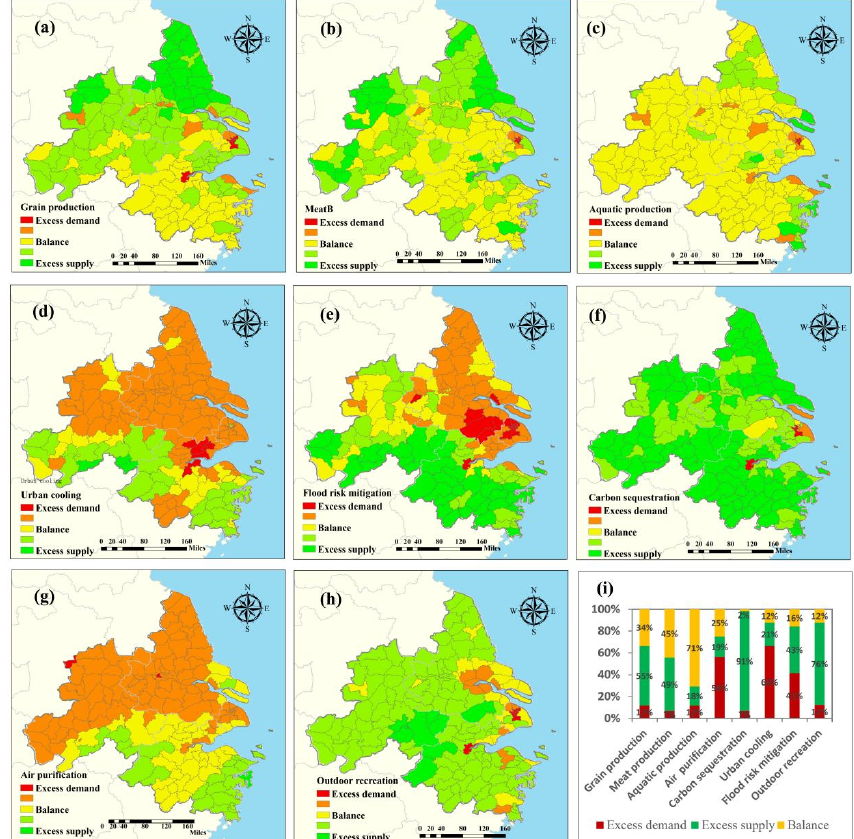
Figure 7. The spatial patterns of paired ES supply–demand ratios ( a – h ) and the proportion of each relationship type for the eight ES ( i ).